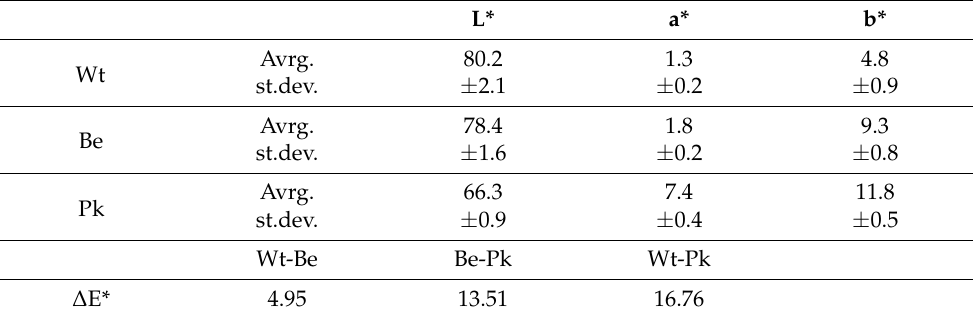
Table 4. Results of color